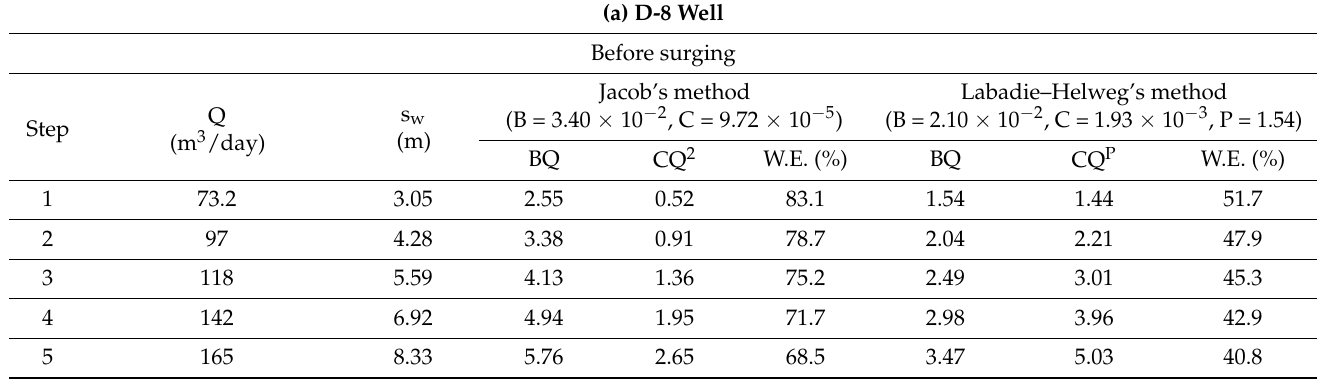
Table 3. Comparisons of well parameters (B, C, P) estimated by Jacob’s and Labadie–Helweg’s methods in the (a) D-8 and (b) D-7 wells before and after air